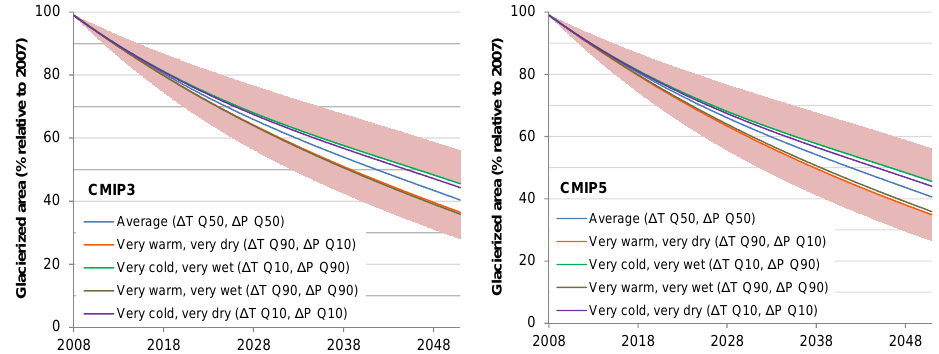
Fig. 13. Decrease in total glacier area in the Amu Darya and Syr Darya basins combined for 2008–2050 based on the CMIP3 (left panel) and CMIP5 (right panel) model runs for the median and extreme values of temperature and precipitation change. The red error range added to the two most extreme cases is derived using an uncertainty analysis on model parameters and observed glacier mass balance information (see Sect. 5.3).